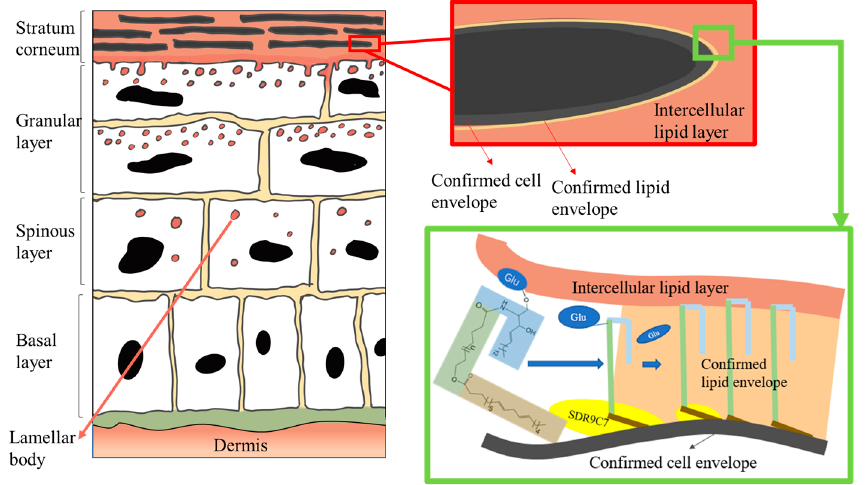
Figure 2. Schematic diagram of epidermal keratinocyte differentiation. Structure of the epidermal barrier and how the CLE is formed, in detail.